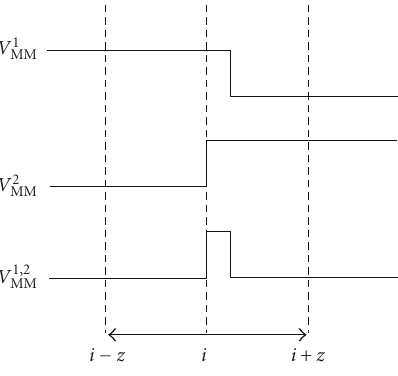
Figure 3: Interruption